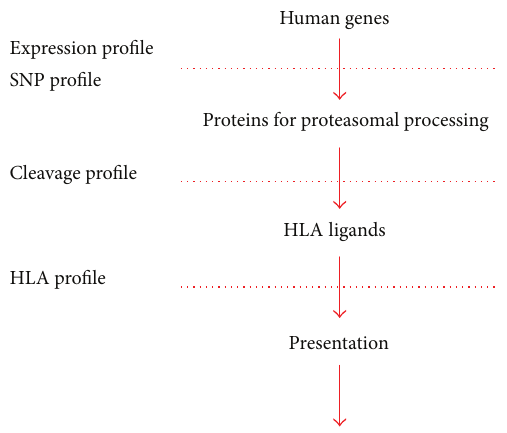
Figure 1: Assessment of targetable allogeneic epitopes. Every ligand has to pass several filters, before being presented in an HLA molecule. The first is the individual expression profile. Proteins then undergo further proteasomal processing, where the individual cleavage profile determines the sequence of possible HLA ligands. ThelastfilteristheindividualHLAprofilethatdiffersbetweenallelic